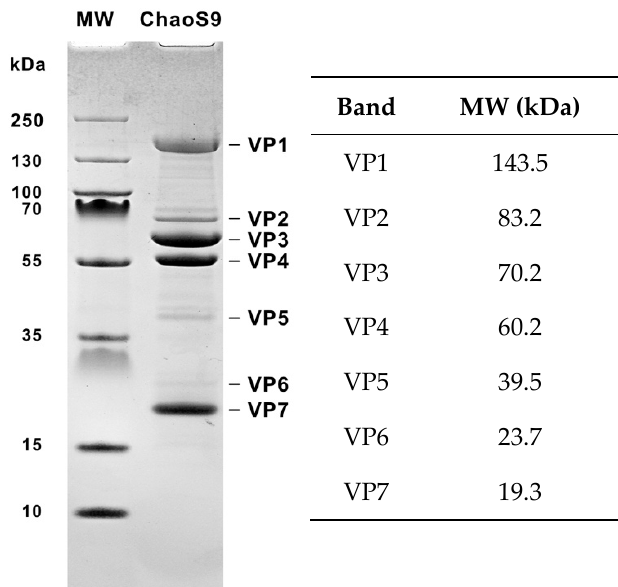
Figure 2. Proteins of halovirus ChaoS9. Purified virus was heated in sample buffer and separated on a 4%–12% SDS-polyacrylamide gel, and the separated proteins stained with Coomassie blue. MW, molecular weight standards (PageRuler). The sizes of the protein standards are indicated at the left (in kDa). Virus proteins (VP1 to VP7) are numbered from largest to smallest. Molecular weight estimates of the major virus proteins are shown in the adjacent table.